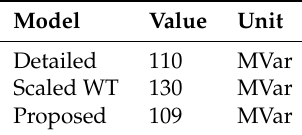
Figure 14. Simulation results showing how system voltage is affected depending on the type of WPP reactive power capability model used. Table 5. Values of maximum reactive power injection capability using different